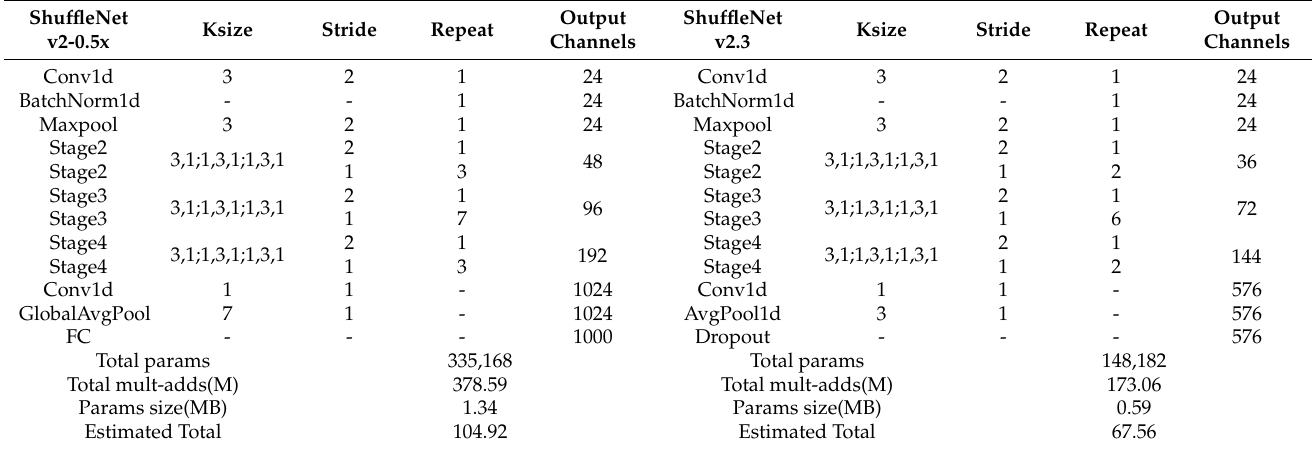
Table 1. Comparison of ShuffleNet v2-0.5x and ShuffleNet v2.3 parameters.